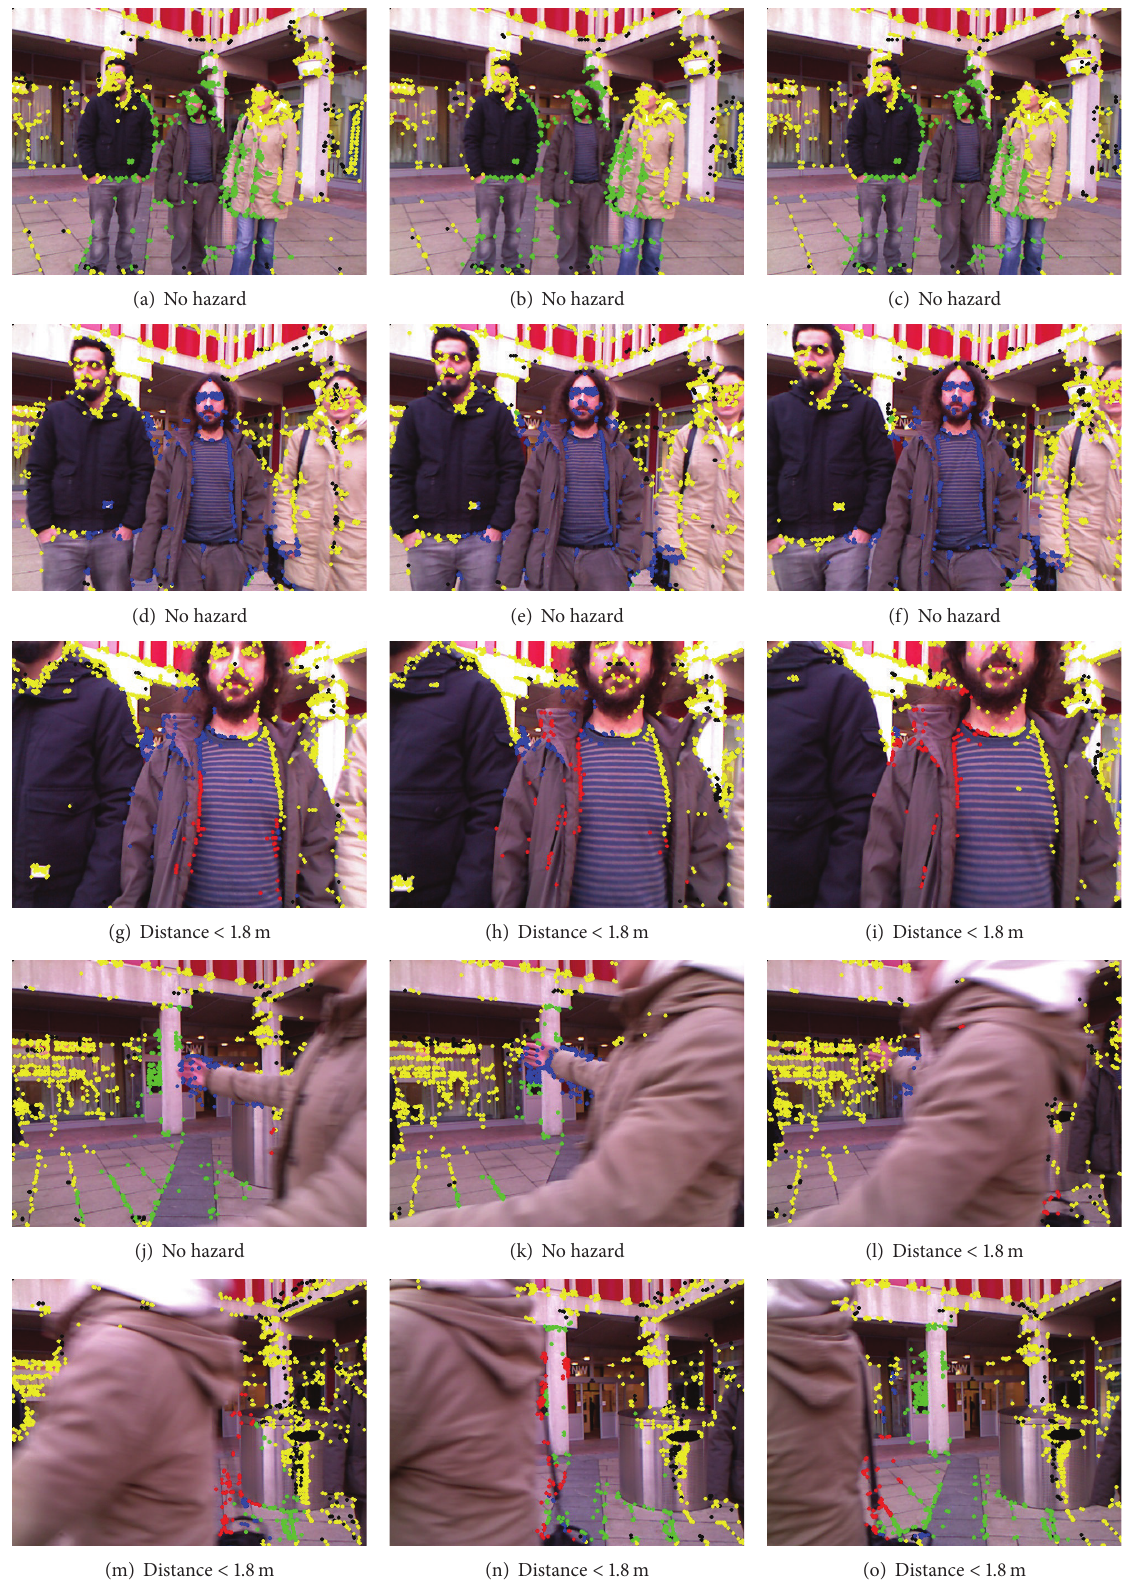
Figure 15: The navigation system’s visual output on an outdoor video sequence with people walking around the subject (blindfolded) as dynamic obstacles. In frame (g), system starts sensing hazard shown with red points but loses it after 3 frames; therefore, no warning is